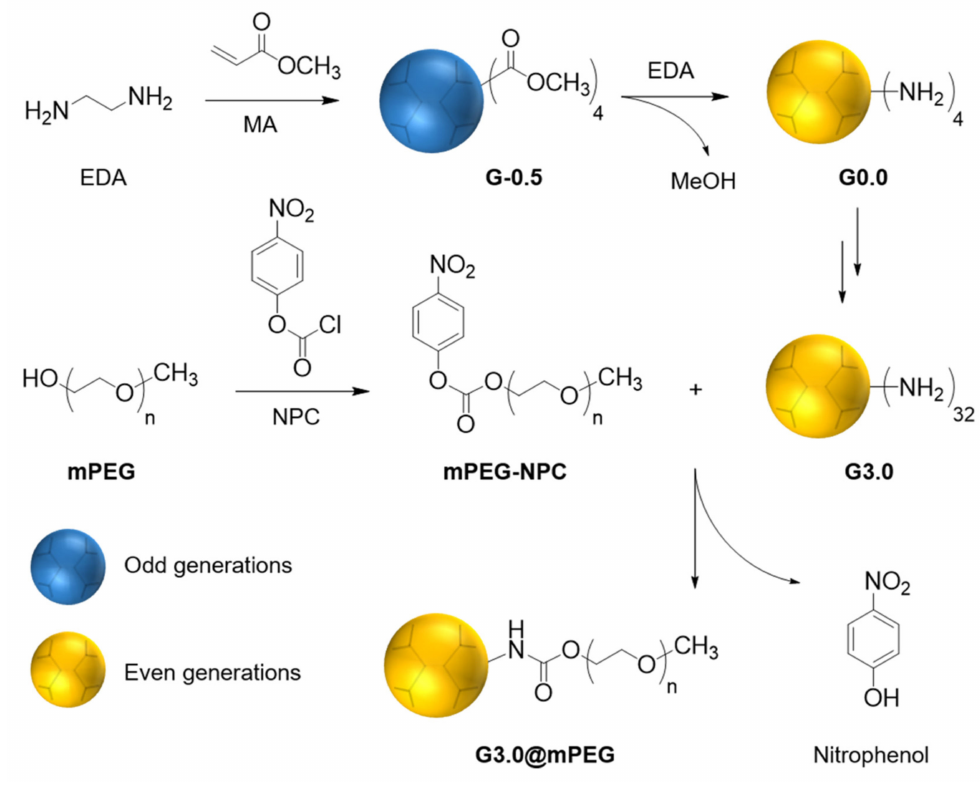
Scheme 1. Schematic representation of the formation of PAMAM G3.0 and PAMAM